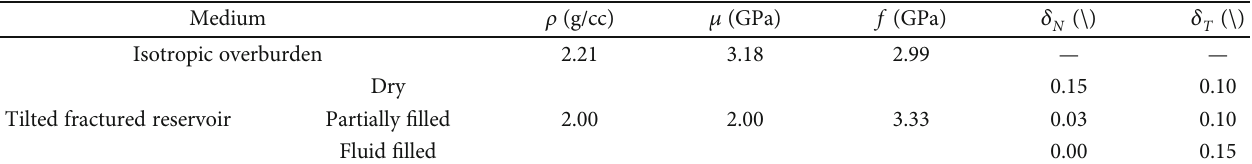
Table 1: Physical properties of an interface separating an isotropic overburden from a tilted fractured medium (modi fi ed from Shaw and Sen,